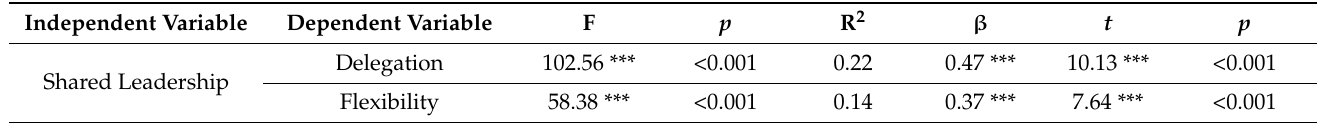
Table 6. Results of the two simple linear regressions (H4).